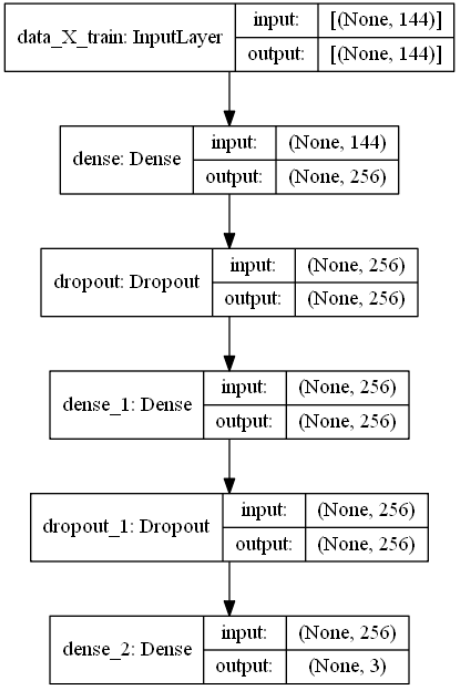
Figure 14. MLP model used in the experiment.